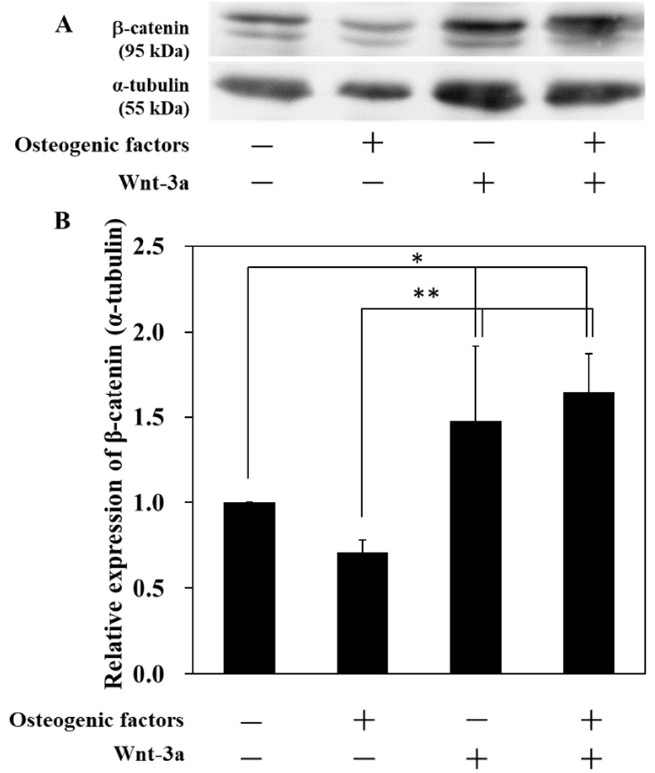
Figure 2. The expression levels of β -catenin after treatment with Wnt-3a. Treatment of HPLFs with Wnt-3a resulted in high expression of β -catenin and activation of Wnt/ β -catenin signaling. HPLFs were treated with osteogenic medium and Wnt-3a for 14 days. ( A , B ) The expression of β -catenin was examined by Western blot analysis. Data represent the means ± S.D. * p < 0.05, ** p < 0.01, (n = 4).